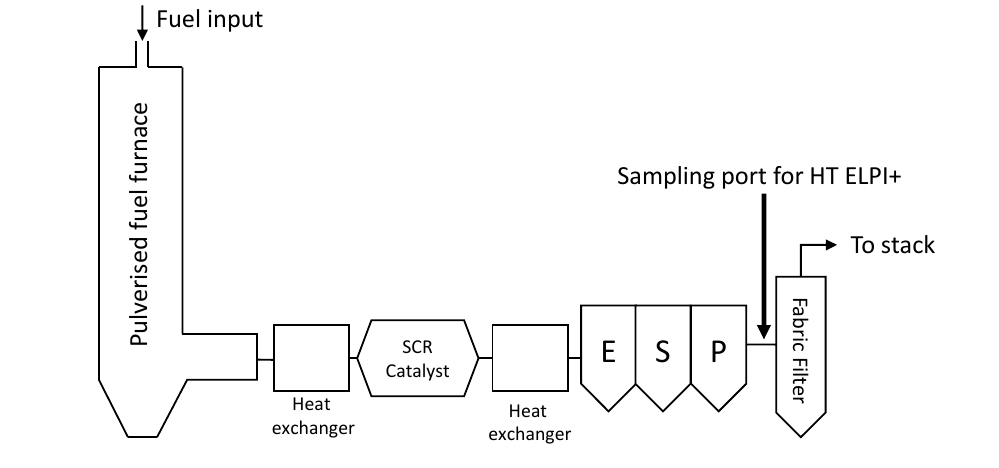
Figure 1. Scheme of 500 kWth test facility KSVA. Table 2. Experimental matrix.